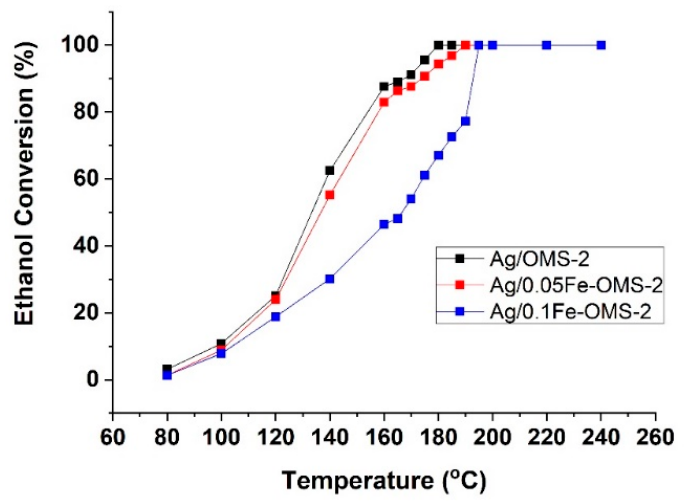
Figure 3. Temperature dependences of ethanol conversion for prepared samples. Reaction conditions: GHSV = 7200 mL g − 1 h − 1 , Et/O 2 = 2/18.